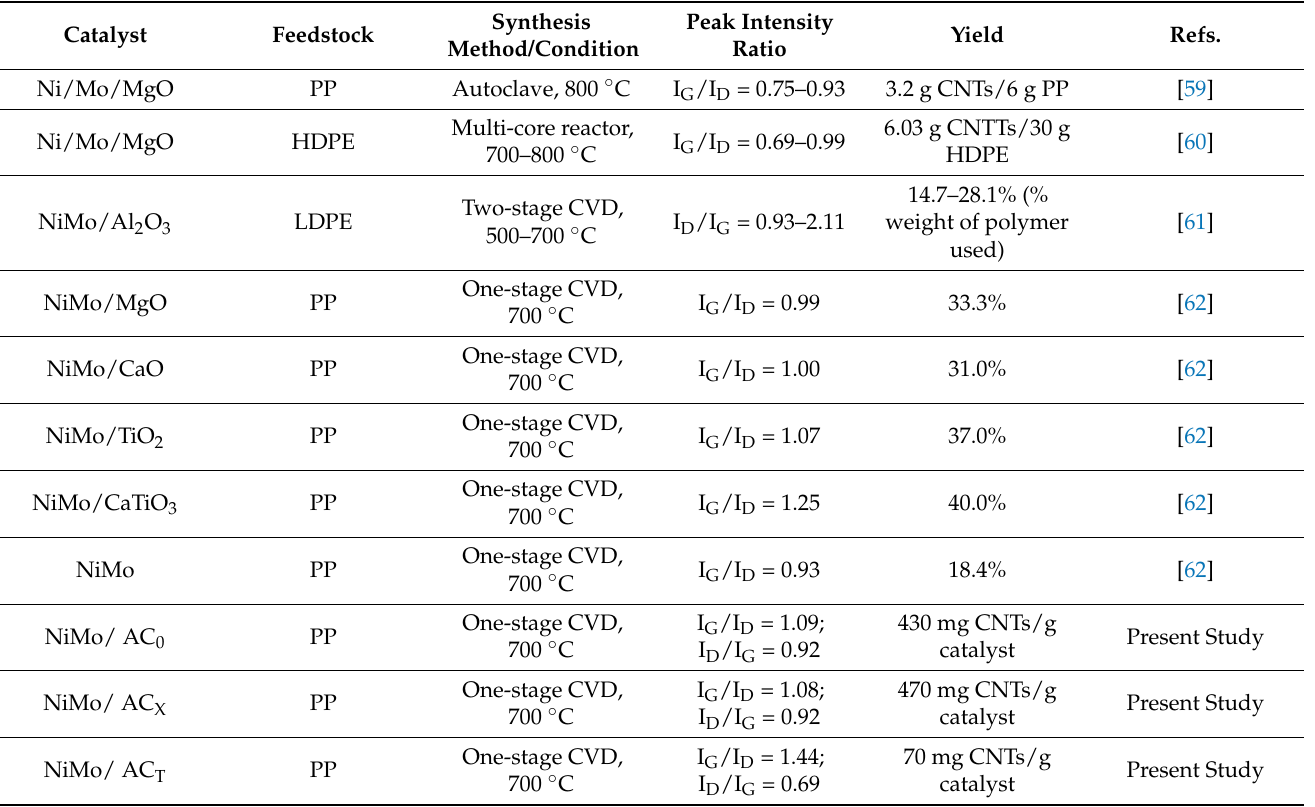
Table 5. Comparison of results obtained from this study with those reported in the